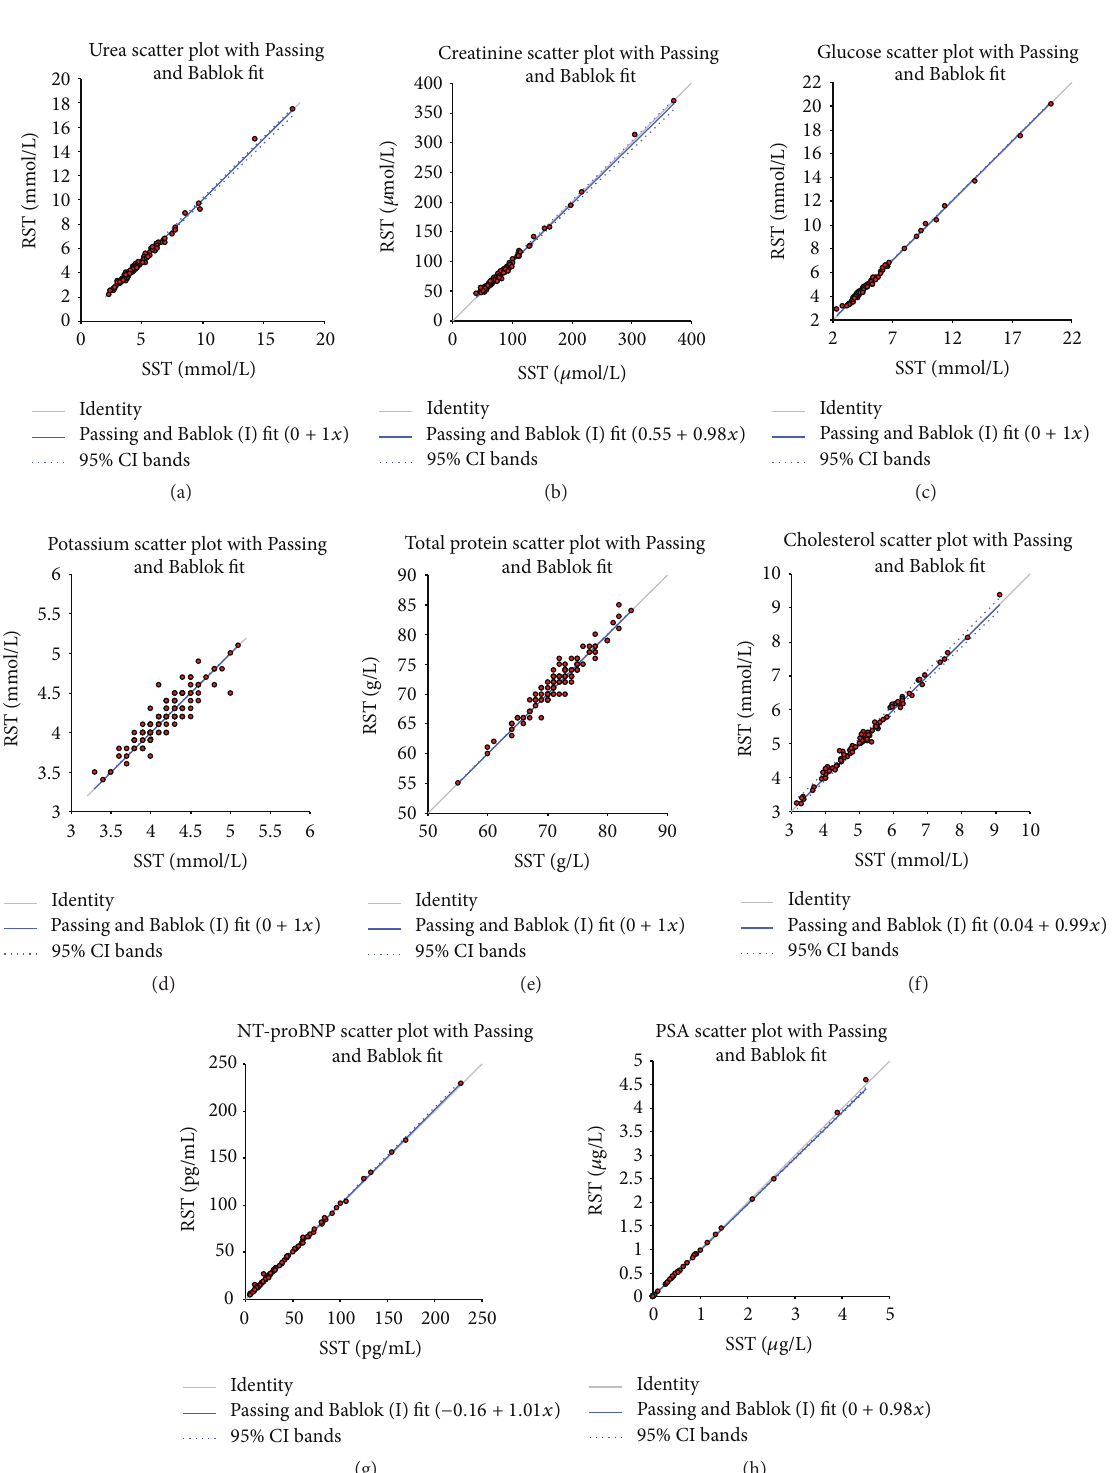
Figure 1: Comparison of results for RST and SST for the select analytes. Select analytes: Passing-Bablok regression analysis. (a) urea, (b) creatinine, (c) glucose, (d) potassium, (e) total protein, (f) cholesterol, (g) NT-proBNP, and (h)